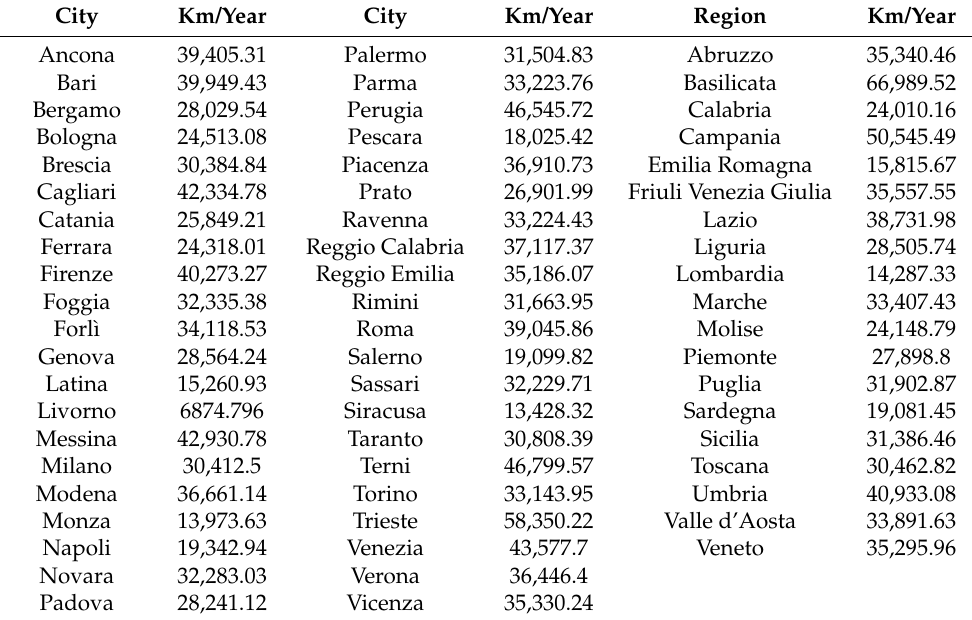
Source: INVITALIA analysis for National Strategic Plan of Sustainable Mobility monitoring.